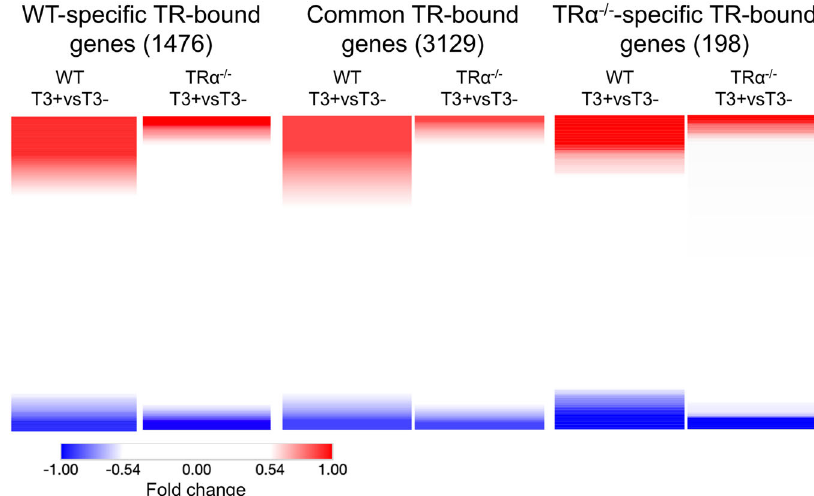
Fig. 5 T3 regulation pro fi le of ChIP-Seq detected genes. Heatmap showing the fold change of gene expression in wild-type or TR α − / − intestine after 18 h T3 treatment as measured by RNA-Seq 19 , for TR-bound genes detected by ChIP-Seq in only the wild-type intestine (left), both wild-type and TR α − / − intestine (middle) or only TR α − / − intestine (right). Note that higher fractions of the TR-bound genes were upregulated (red) or downregulated (blue) by T3 were present in the wild-type-speci fi c or common TR-bound genes than TR α − / − -speci fi c TR-bound genes and that TR α knockout reduced T3- regulation, i.e., leading to lighter red or blue, for individual genes, suggesting that TR α − / − is important for gene regulation during the treatment. Note that the blank region between the red and blue areas are genes whose expression has no or little change after T3 treatment of wild-type or TR α knockout animals. The color range shows fold changes in log2